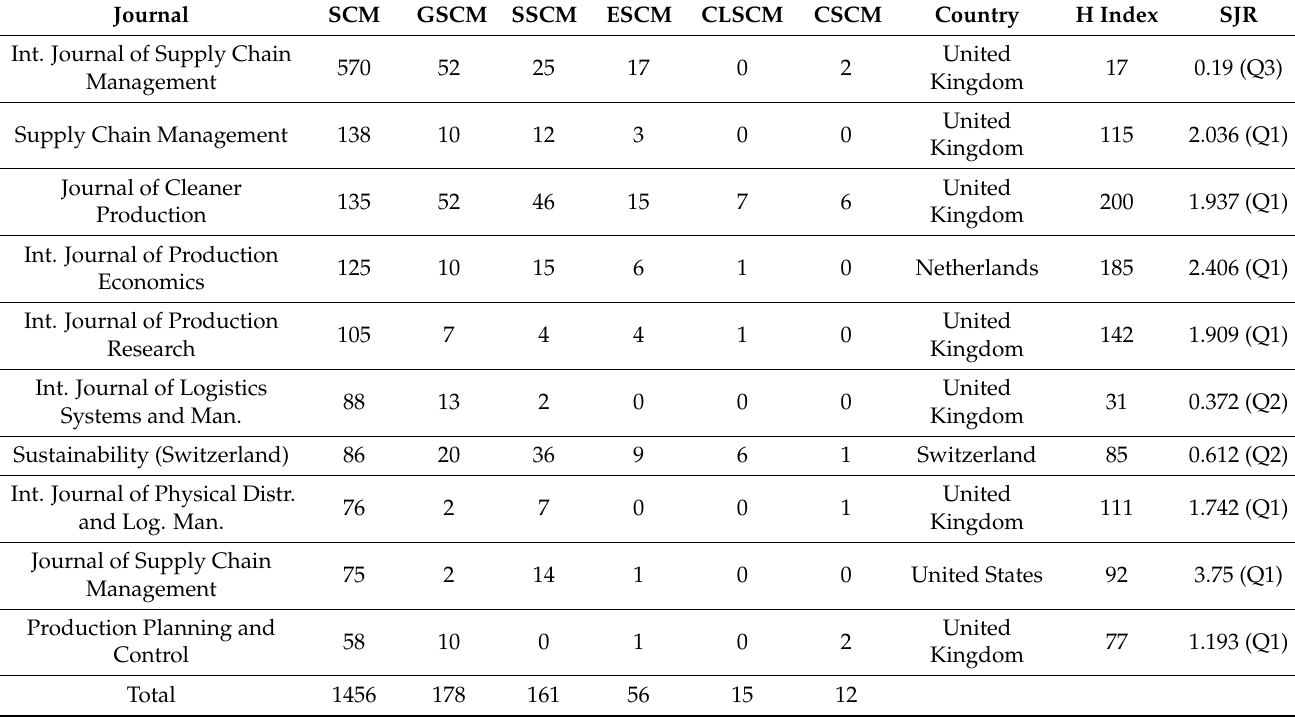
Table 4. Journals with the largest number of